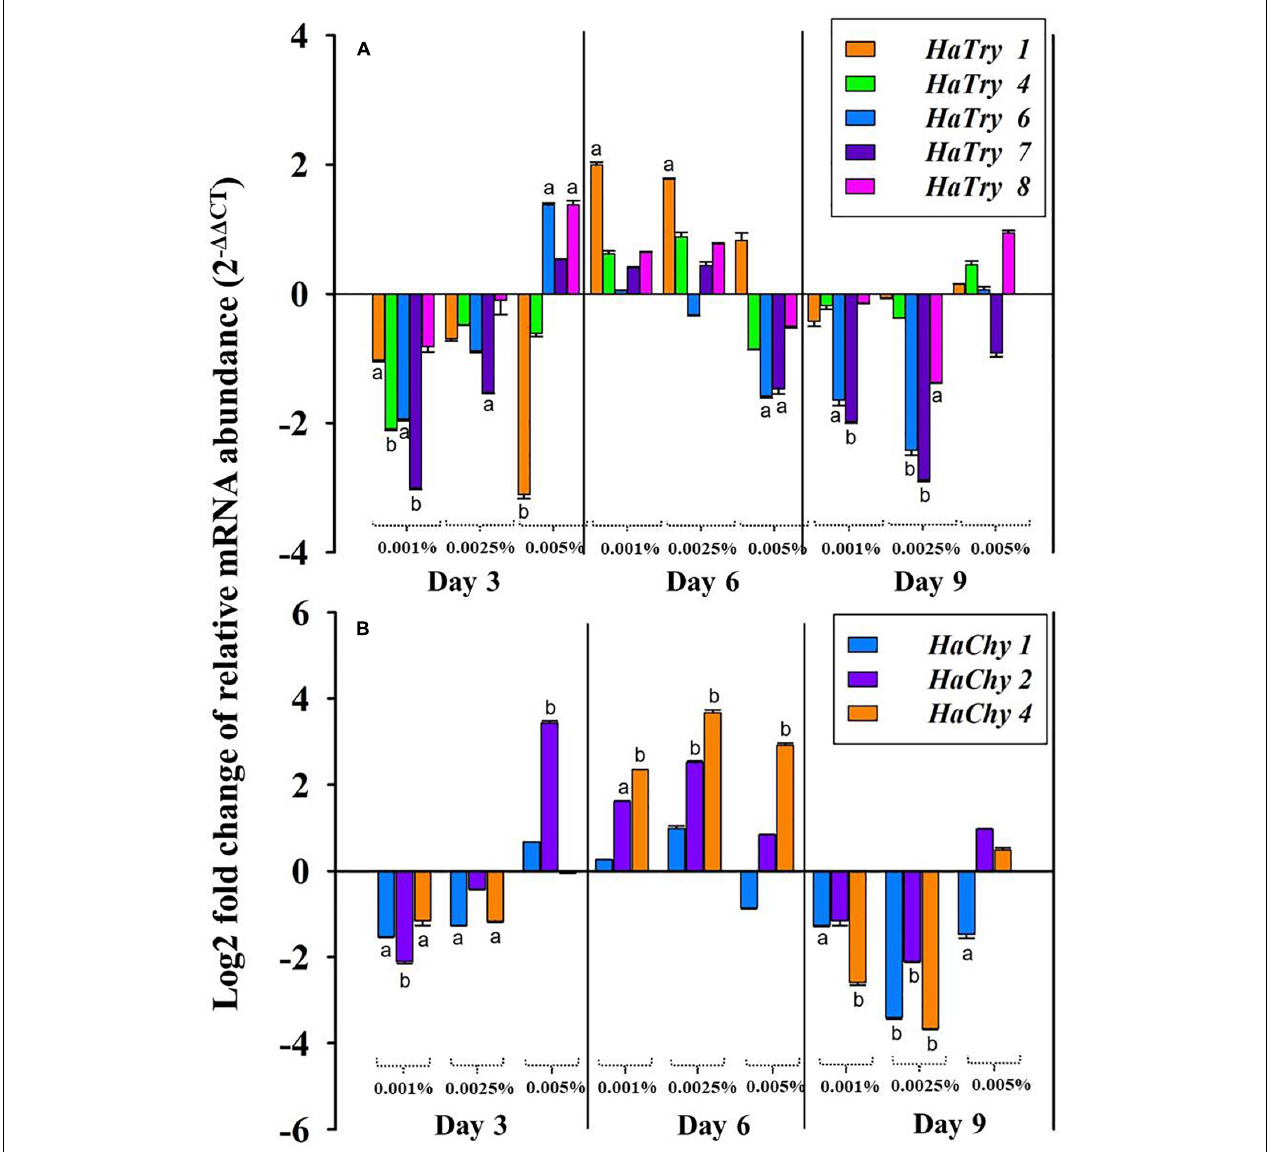
FIGURE 9 | qRT-PCR analysis of midgut serine proteases of H. armigera larvae fed on PnBBI. Changes in transcript abundance of (A) midgut trypsin-like ( HaTry 1, 4, 6, 7, and 8) and (B) chymotrypsin-like ( HaChy 1, 2, and 4) proteases from midgut tissue of H. armigera larvae after rearing on artificial diet containing different concentration of PnBBIs (0, 0.001, 0.0025, and 0.005%) for 3, 6, and 9 days. The fold difference in transcript abundance of these candidate genes was calculated using Livak (2 - (cid:49)(cid:49) CT ) method and final values are expressed in log (base2) fold changes. Further details were as described in the methods section “RNA Isolation and Quantitative Real-Time PCR (qRT-PCR).” The data shown is mean ± SD of triplicates. The transcript abundance of trypsin and chymotrypsin-like genes for the larvae fed on PnBBI incorporated diet was compared with control diet-fed larvae in which lower case letters “a and b” assigned for transcripts which showed > 1 and 2-fold difference in their abundance,